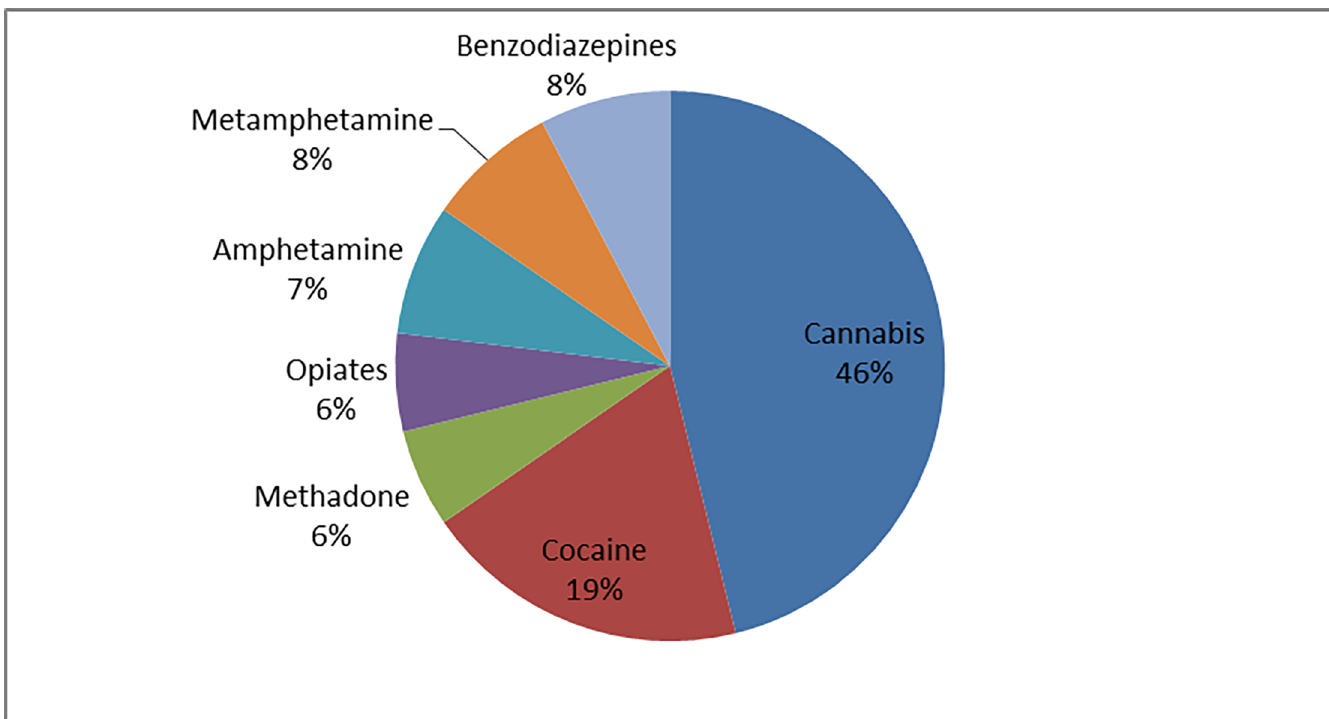
Fig 4. Substances detected with the urine drug screening immunoassay (n = 35).